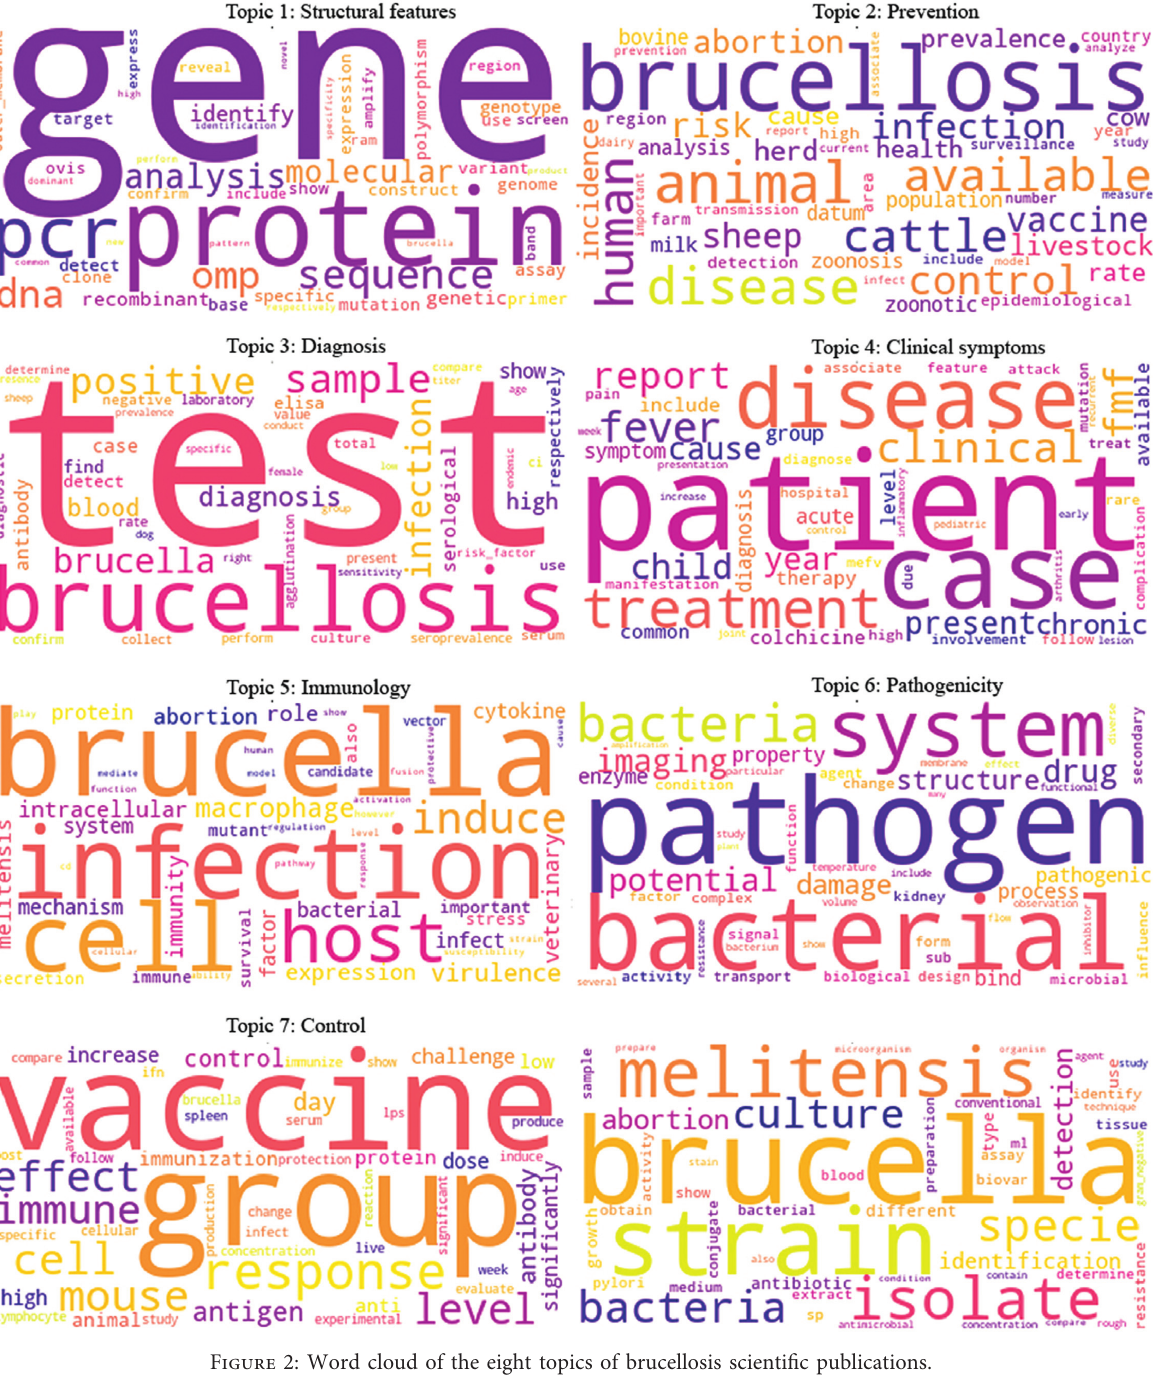
Figure 2: Word cloud of the eight topics of brucellosis scientific